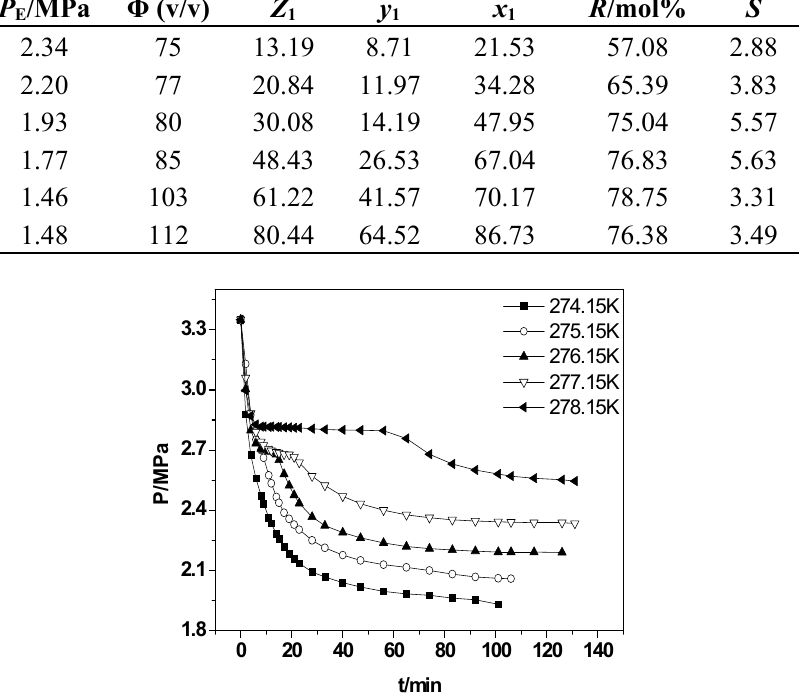
Table 6. Vapor-hydrate equilibrium data for C 2 H 4 /CH 4 binary system in diesel-water emulsion with respect to six feed gas mixtures with different compositions while temperature, initial pressure, and water cut are 274.15 K, 3.4 MPa, and 30 vol%, respectively. P /MPa E